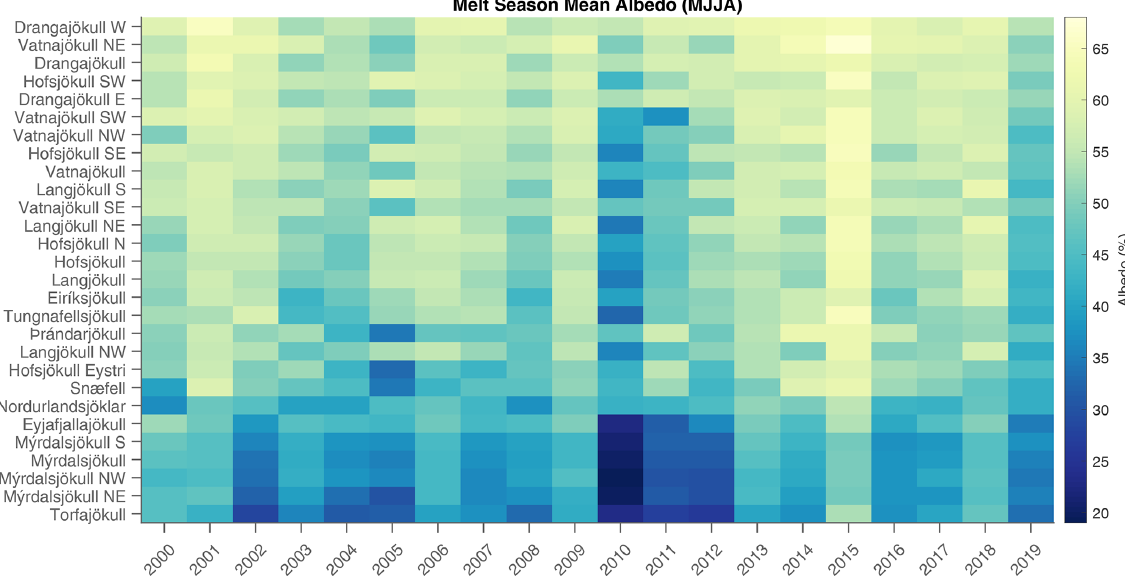
Figure 7. Average melt season albedo for the studied glaciers. The glaciers are sorted from the lowest 2000–2019 melt season average albedo to the highest. For the larger glaciers, data are provided for individual ice flow basins; see Fig. 1.